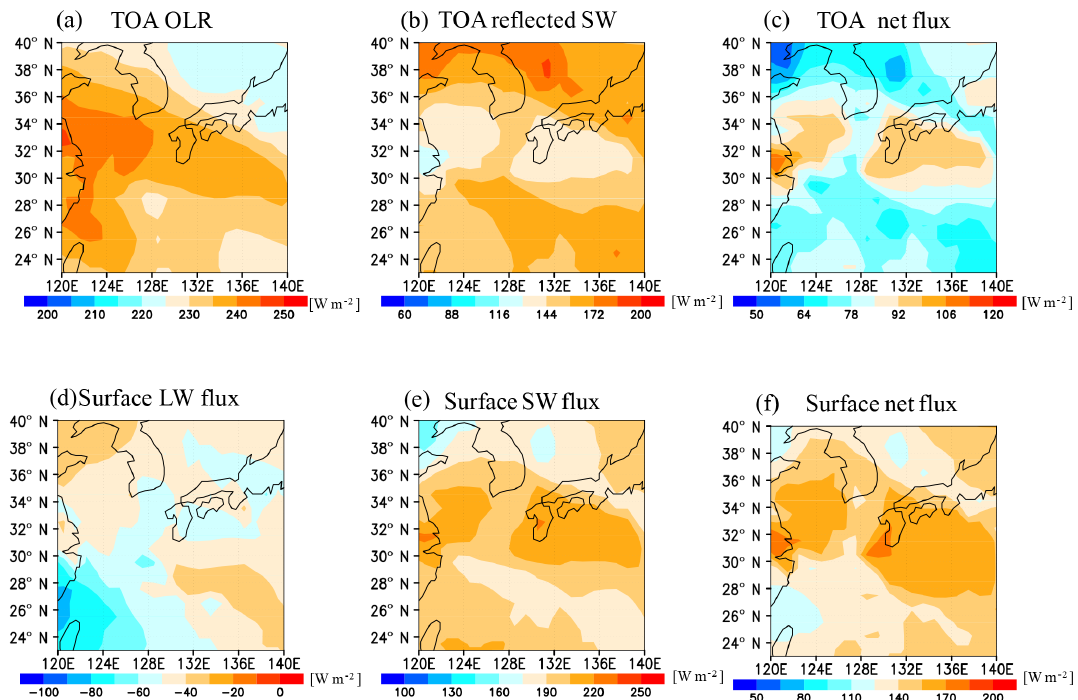
Figure 3. (a) Mean outgoing longwave radiation (OLR) at top of atmosphere (TOA) (Wm − 2 ), (b) mean reflected shortwave radiation at TOA (Wm − 2 ), (c) mean net (SW + LW) radiation at TOA (Wm − 2 ), (d) mean net longwave radiation at surface (Wm − 2 ), (e) mean net shortwave radiation at surface (Wm − 2 ), and (f) mean net radiation at surface (Wm − 2 ) for the target period using EBAF